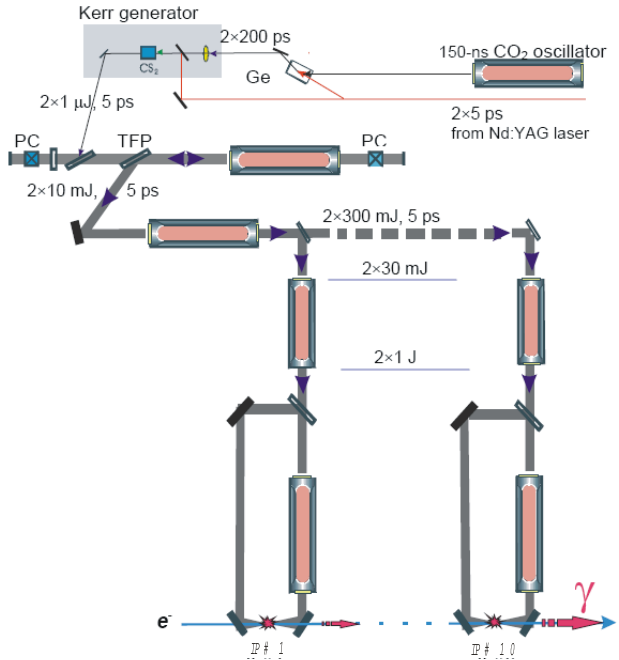
FIG. 2. (Color) Proposed layout of a polarized gamma source based on Compton scattering inside resonator cavities in a series laser amplifiers. PC stands for Pockels cell, TFP—thin of CO 2 film